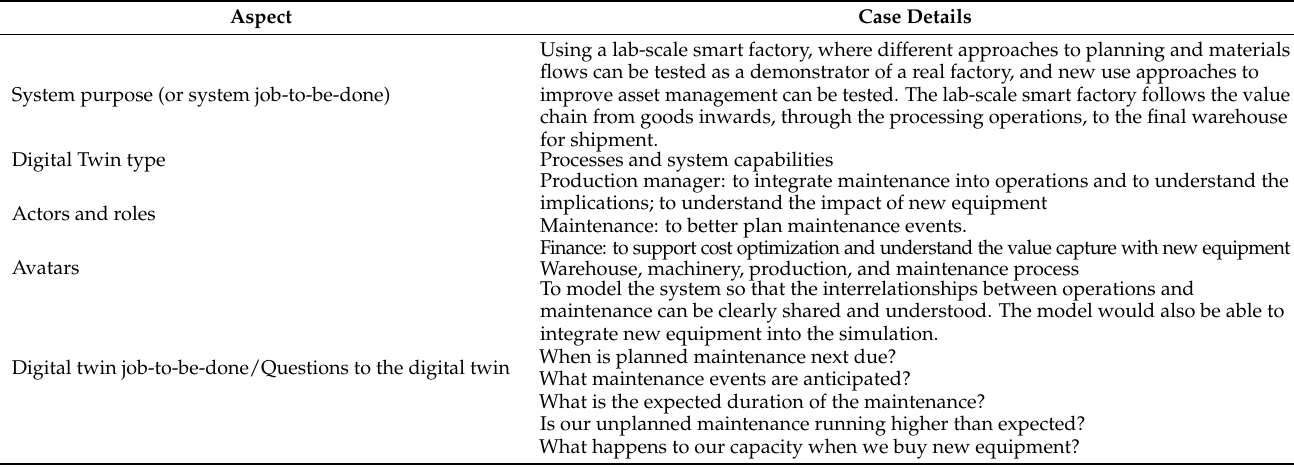
Table A7. Case 5—smart factory asset